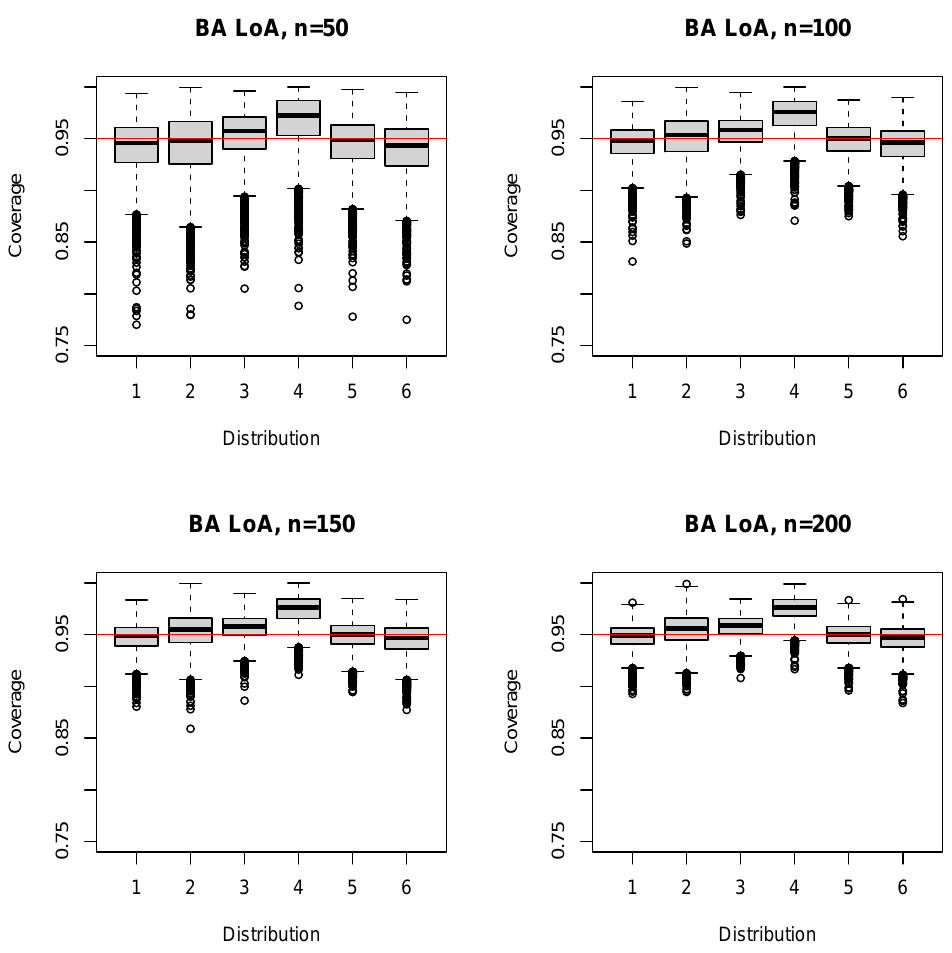
Figure 2. Boxplots of the coverage probability for the BA LoA and n = 50 ( 50 )